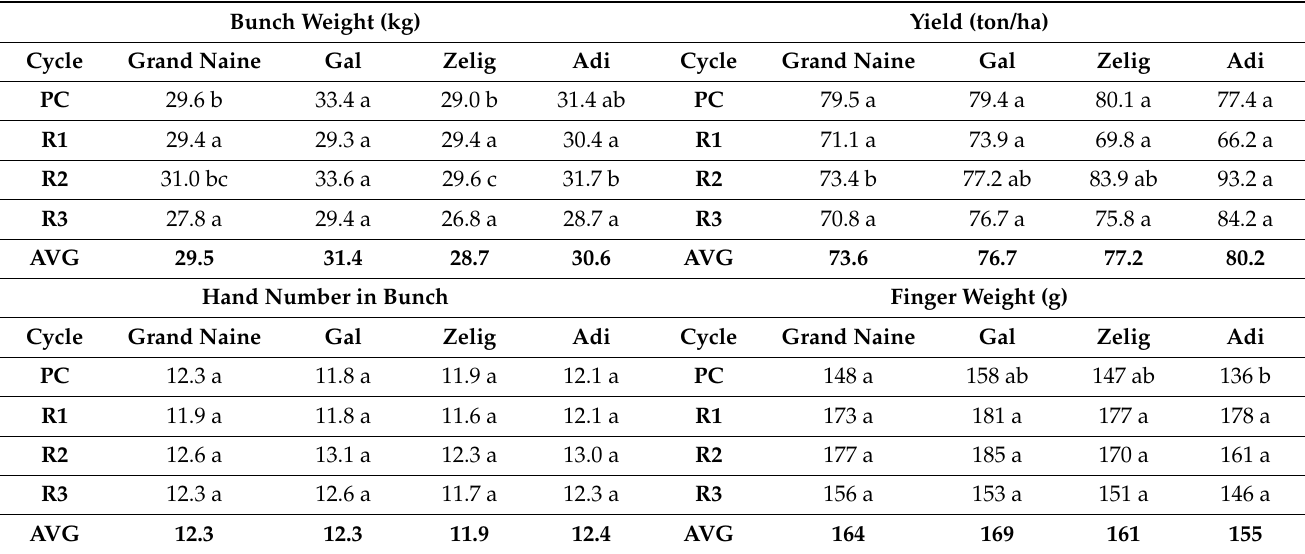
Table 3. Yield parameters for the various cultivars in each crop cycle and average of all cycles ( n = 150 plants/cultivar). AVG is the mean of PC–R3 for all traits. Values in a row followed by the same letter are not significantly different ( p > 0.05).